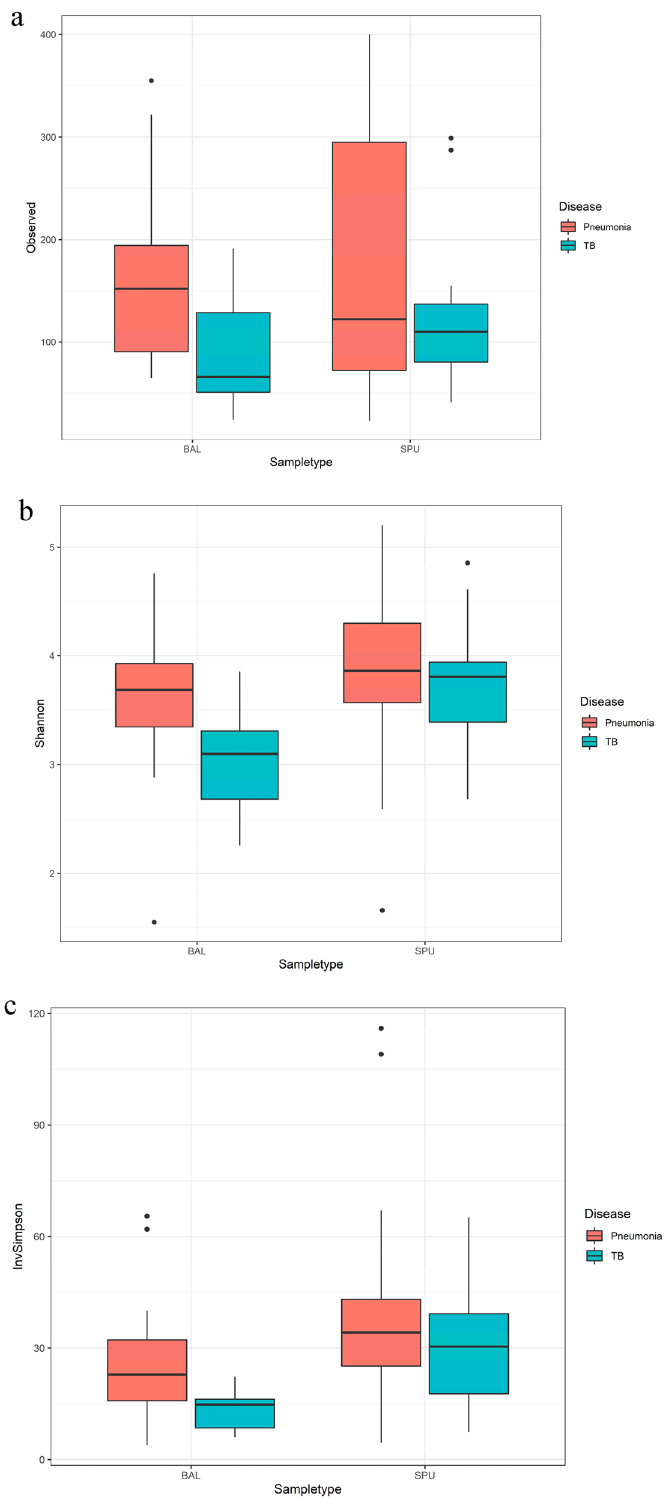
Figure 6. Alpha diversity in the BALF and sputum of Pneumonia and TB cohorts by Observed ( a ), Shannon ( b ) and Inverse simpson ( c )